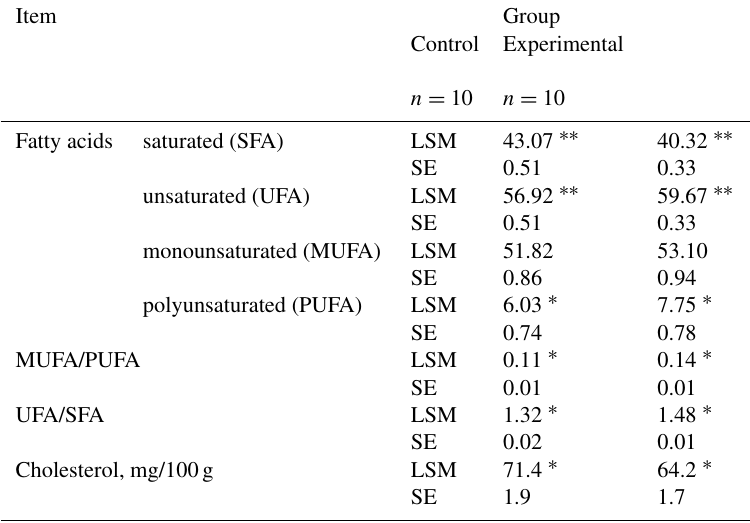
Control Experimental n = 10